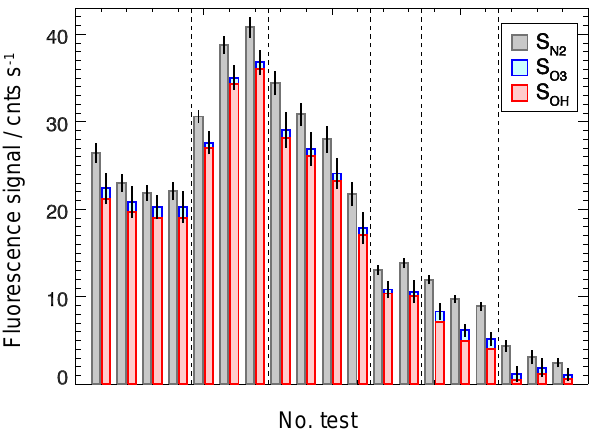
Figure 2. Results of chemical OH modulation tests performed dur- ing the campaign. In each test, the total measured OH signal without OH scavenger ( S N ) is compared to the sum of the known contribu- 2 tions from ambient OH ( S OH ) and the interference from O 3 ( S O The error bars denote the 1 σ statistical error. A fluorescence signal of 30cntss − 1 (counts per second) corresponds to an OH concentra- tion of 1.0 × 10 7 cm − 3